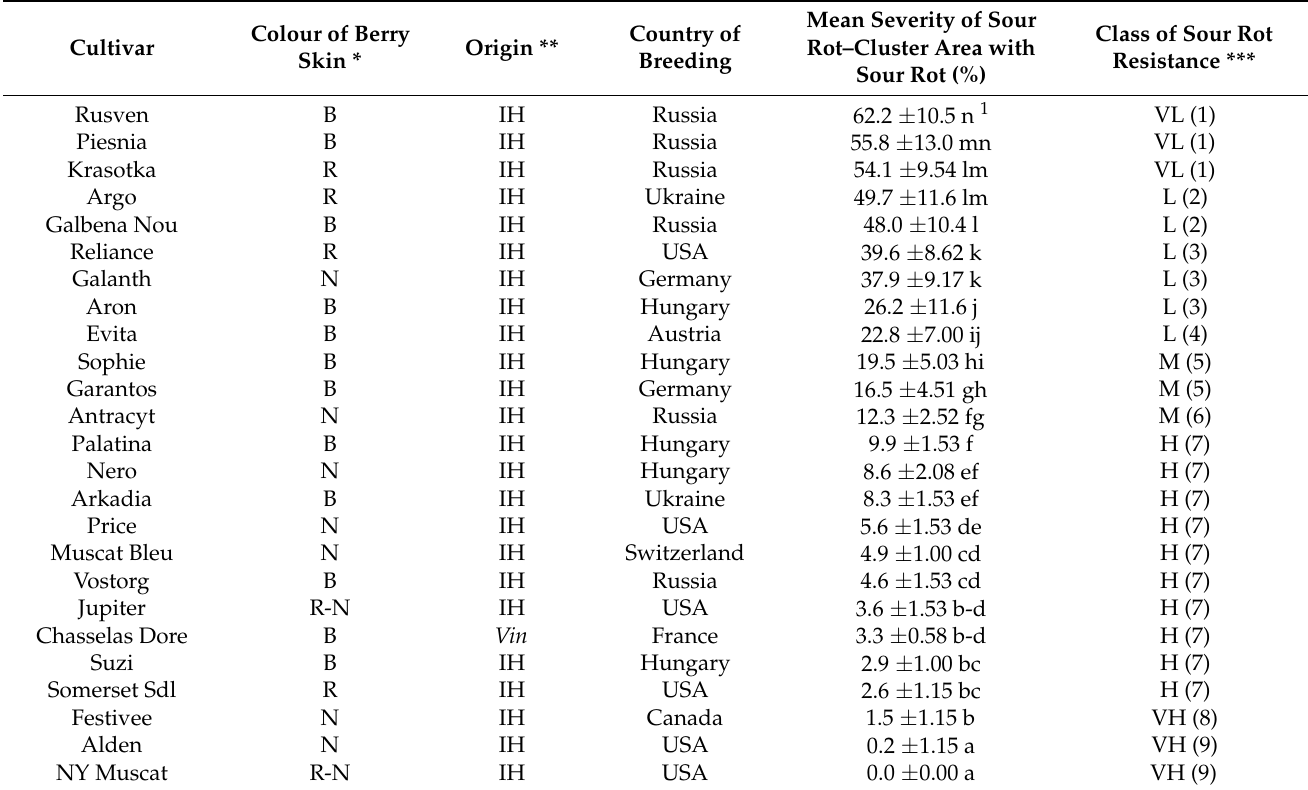
Table 3. Severity of infestation and resistance of table cultivars to sour bunch